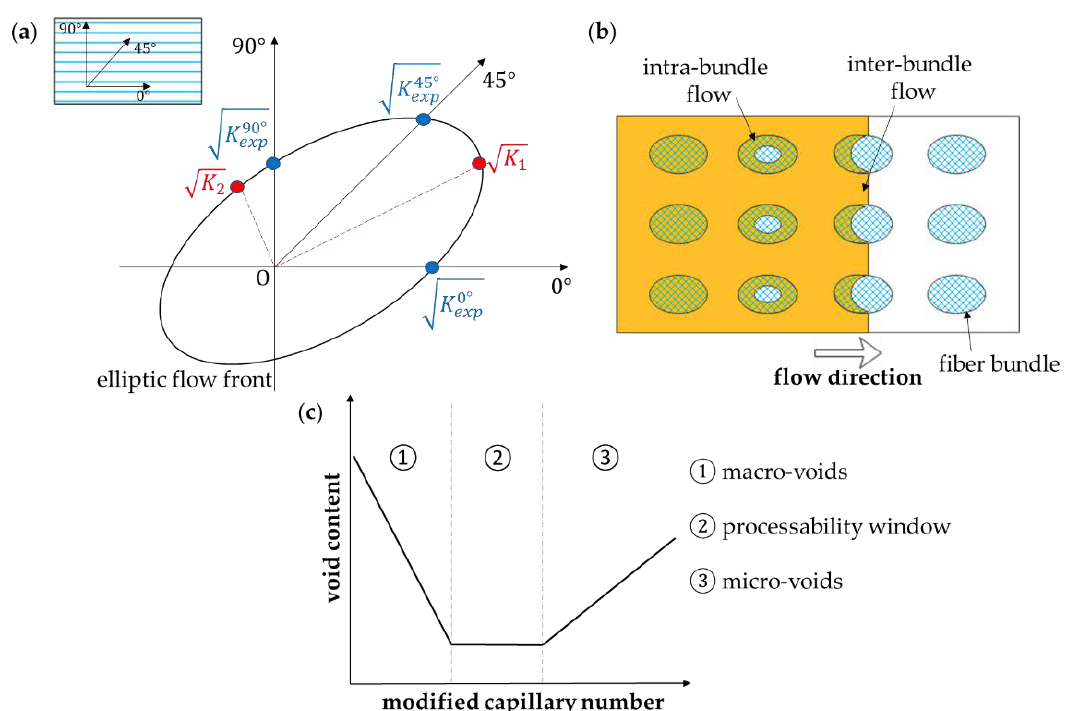
Figure 2. ( a ) In-plane elliptic flowing pattern with the square roots of K 1 and K 2 as the major and minor semi-axis, respectively ([33] Copyright (2007) with permission from John Wiley and Sons), ( b ) illustration of the dual-scale flow ([35] Copyright (2006) with permission from Elsevier), and ( c ) a typical plot of the void content versus the modified capillary number ([36] Copyright (2006) with permission from Elsevier).